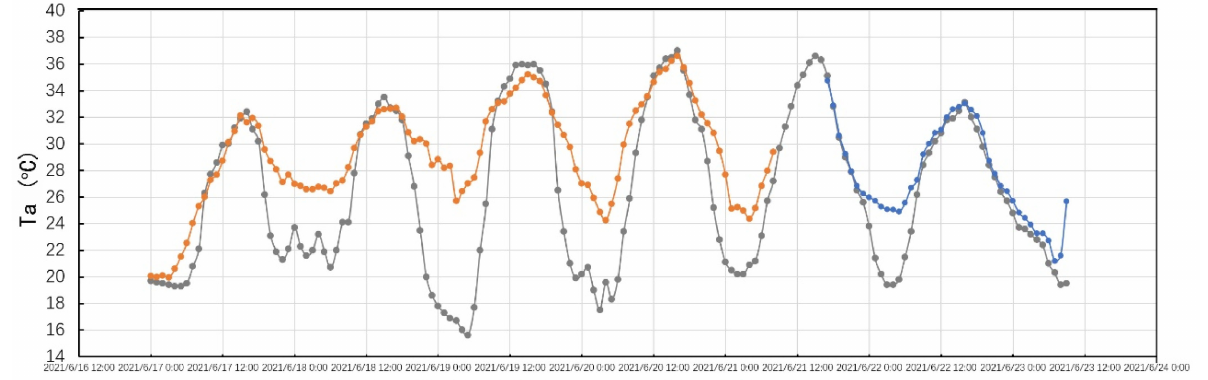
Figure 6. Air temperature of Haidian weather station (17–23 June), Shuangqing Estate (17–20 June), Xueqing Estate (22–23